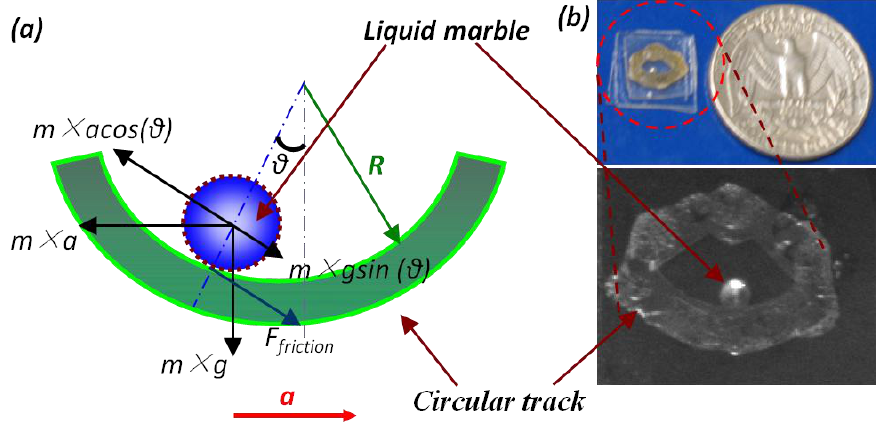
Figure 9. The improved design of liquid-state motion sensor with a curved channel. (a) the schematic and (b) the